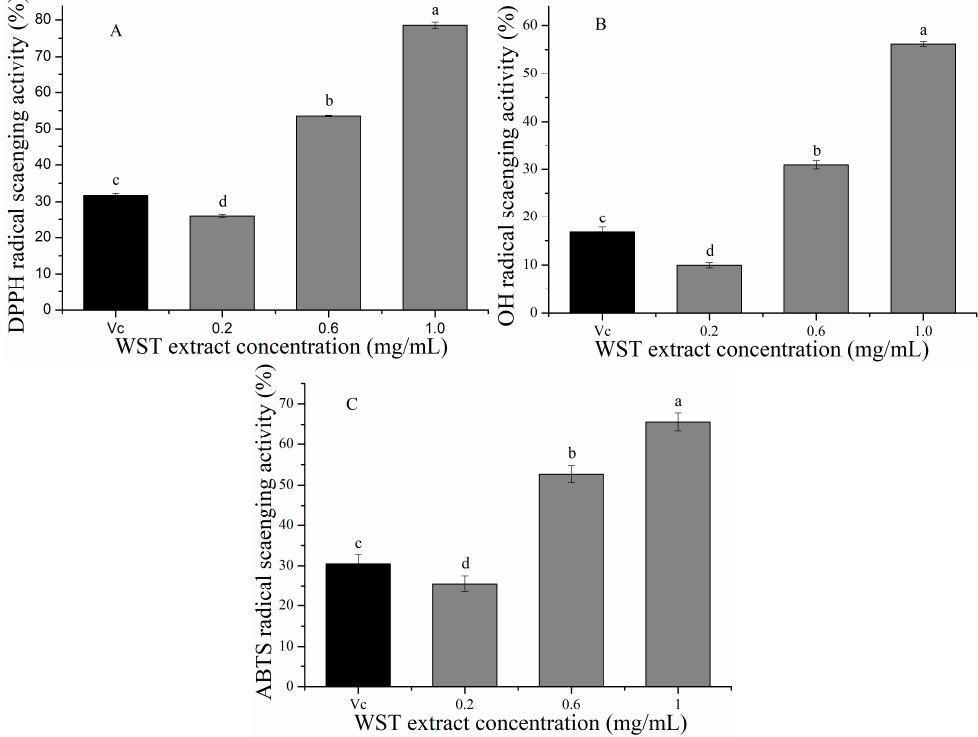
Figure 1. Scavenging activity of Wushanshencha (WST) extracts towards 1, 1-diphenyl-2-picrylhydrazyl radical (DPPH), hydroxyl radicals (OH), and 2, 2’-azino-bis (3-ethylbenzthiazoline-6-sulphonic acid) diammonium salt radicals (ABTS). ( A ): DPPH radical; ( B ): OH radical; ( C ): ABTS radical. Ascorbic acid was used as positive control in anti-oxidant experiments. a–d Mean values with different letters in the same bar graph are significantly different ( p < 0.05) according to Duncan’s multiple range test.